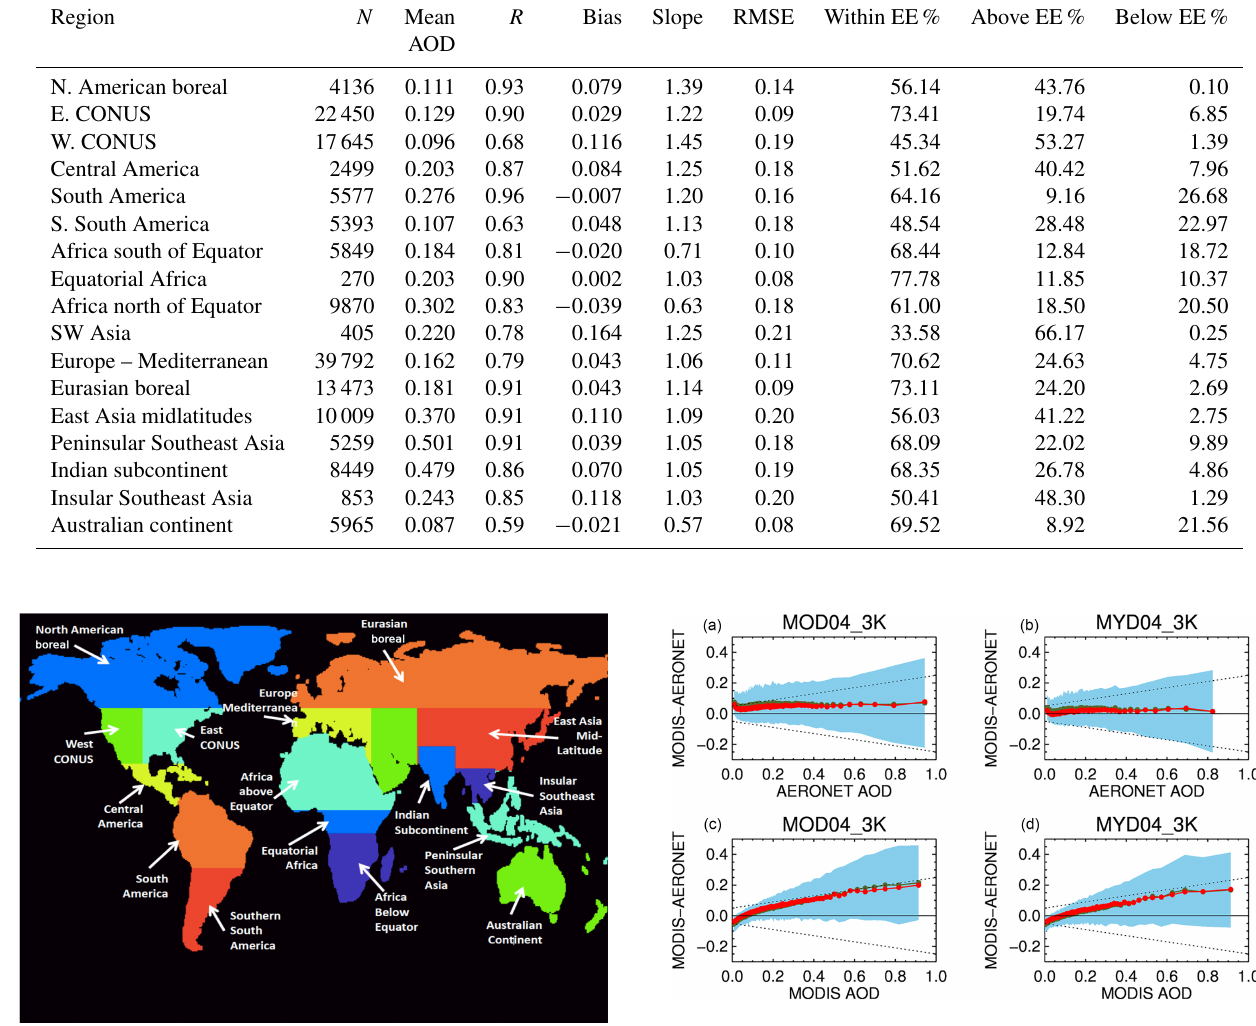
Figure 5. Map showing 17 selected parts of the world where re- gional analysis is performed.